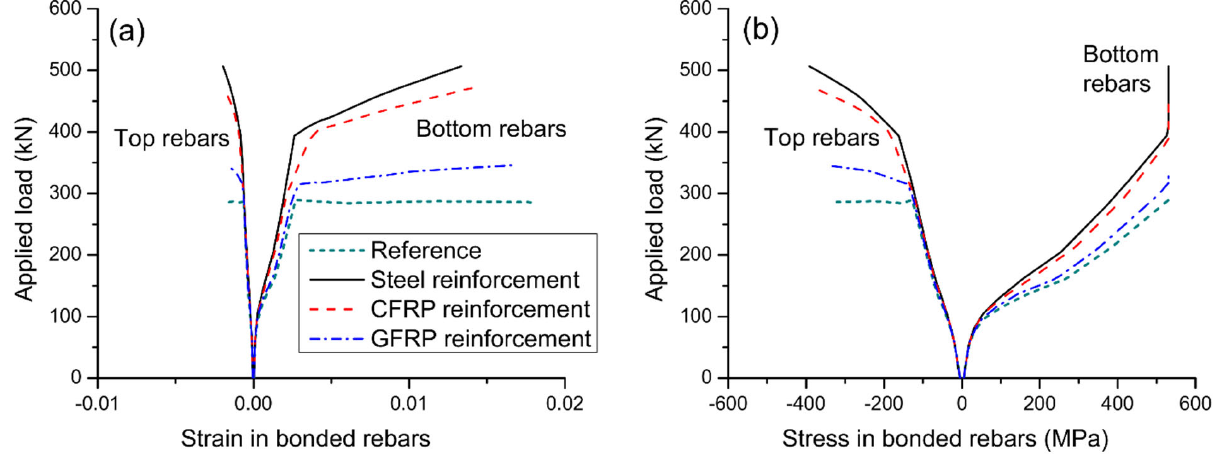
Figure 7. Effect of reinforcement type on the behavior of bonded rebars at midspan. ( a ) development of rebar strain; ( b ) development of rebar stress.